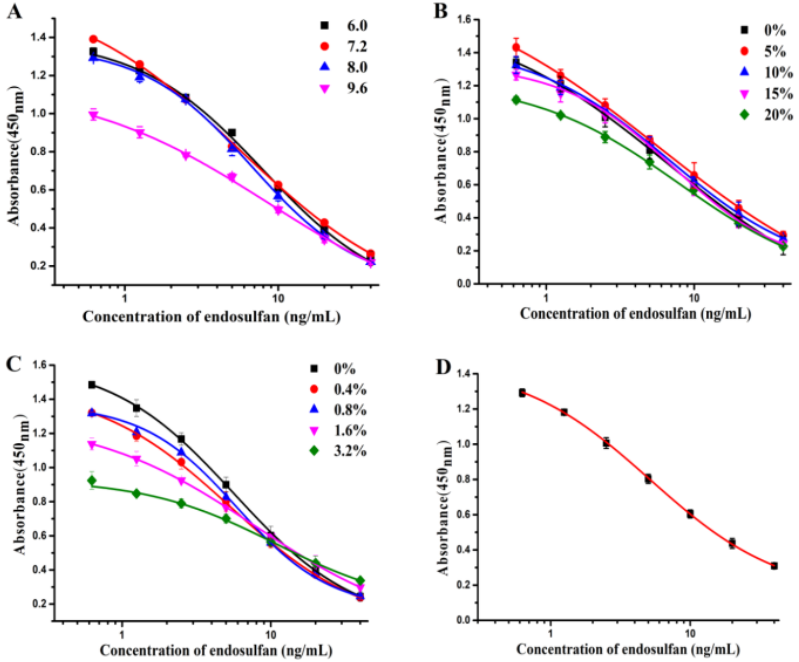
Figure 8. The optimization of the ic-ELISA. ( A ) pH values; ( B ) methyl alcohol content; ( C ) NaCl content; ( D ) The standard curves of endosulfan using the ic-ELISA. (n = 3).